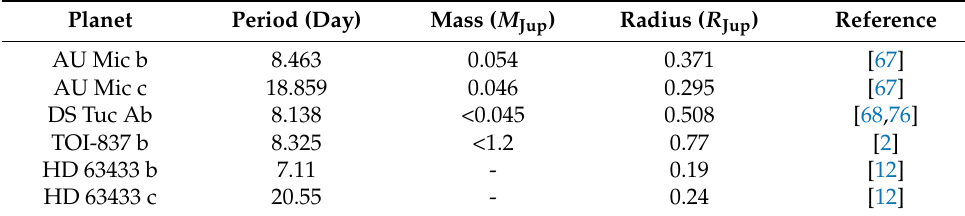
Table 3. Properties of confirmed exoplanets.